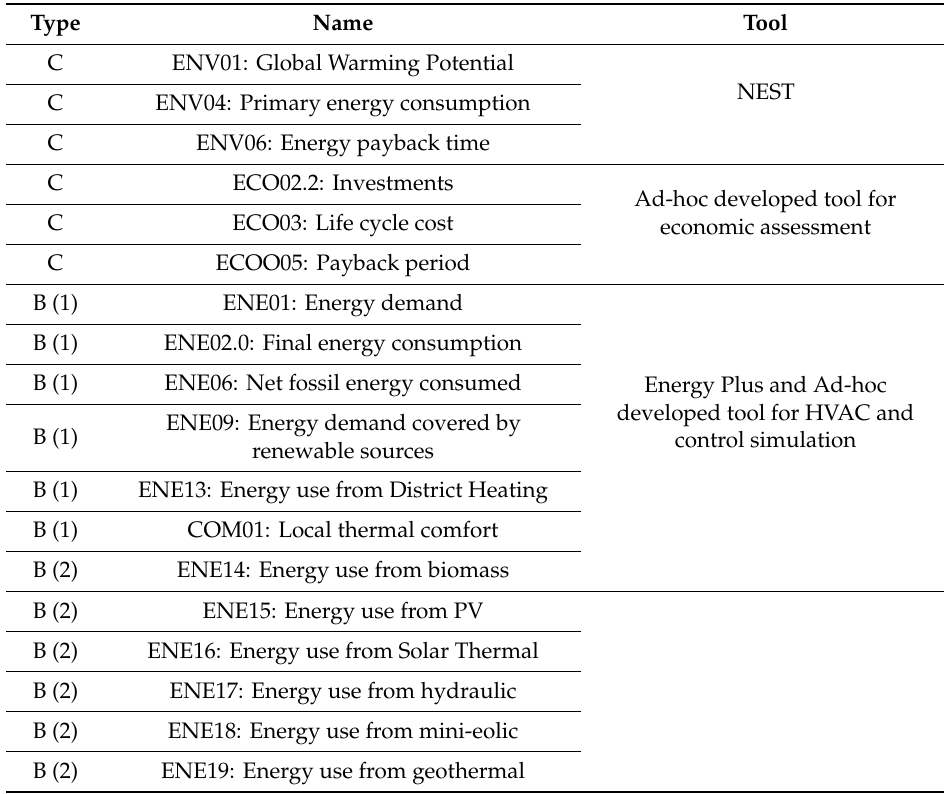
Table 9. List of tools used to calculate the